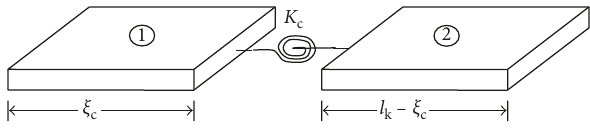
Figure 4: Cracked beam